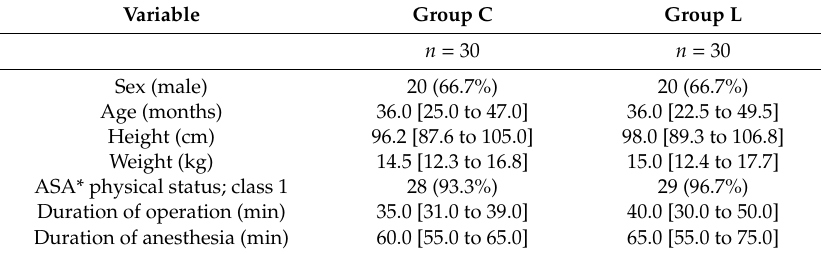
Table 1. Baseline characteristics of the patients included in the two study groups.